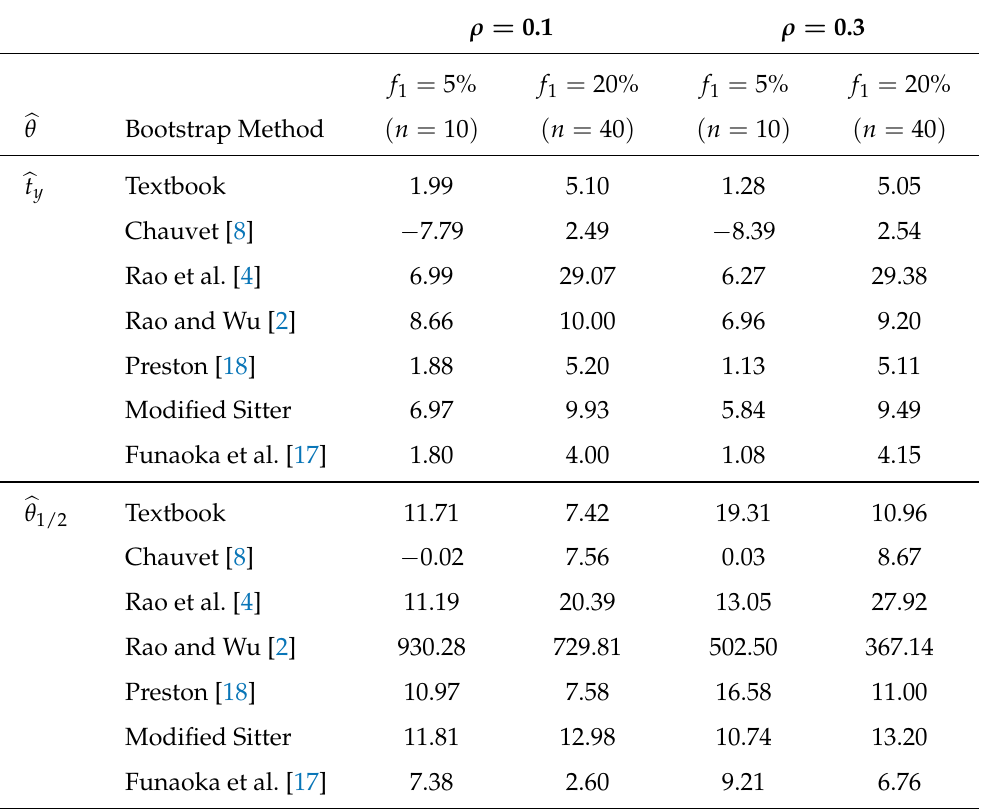
Table 2. Monte Carlo percent RB of the bootstrap variance estimators to estimate the variance of the point estimator based on 3000 samples selected according to